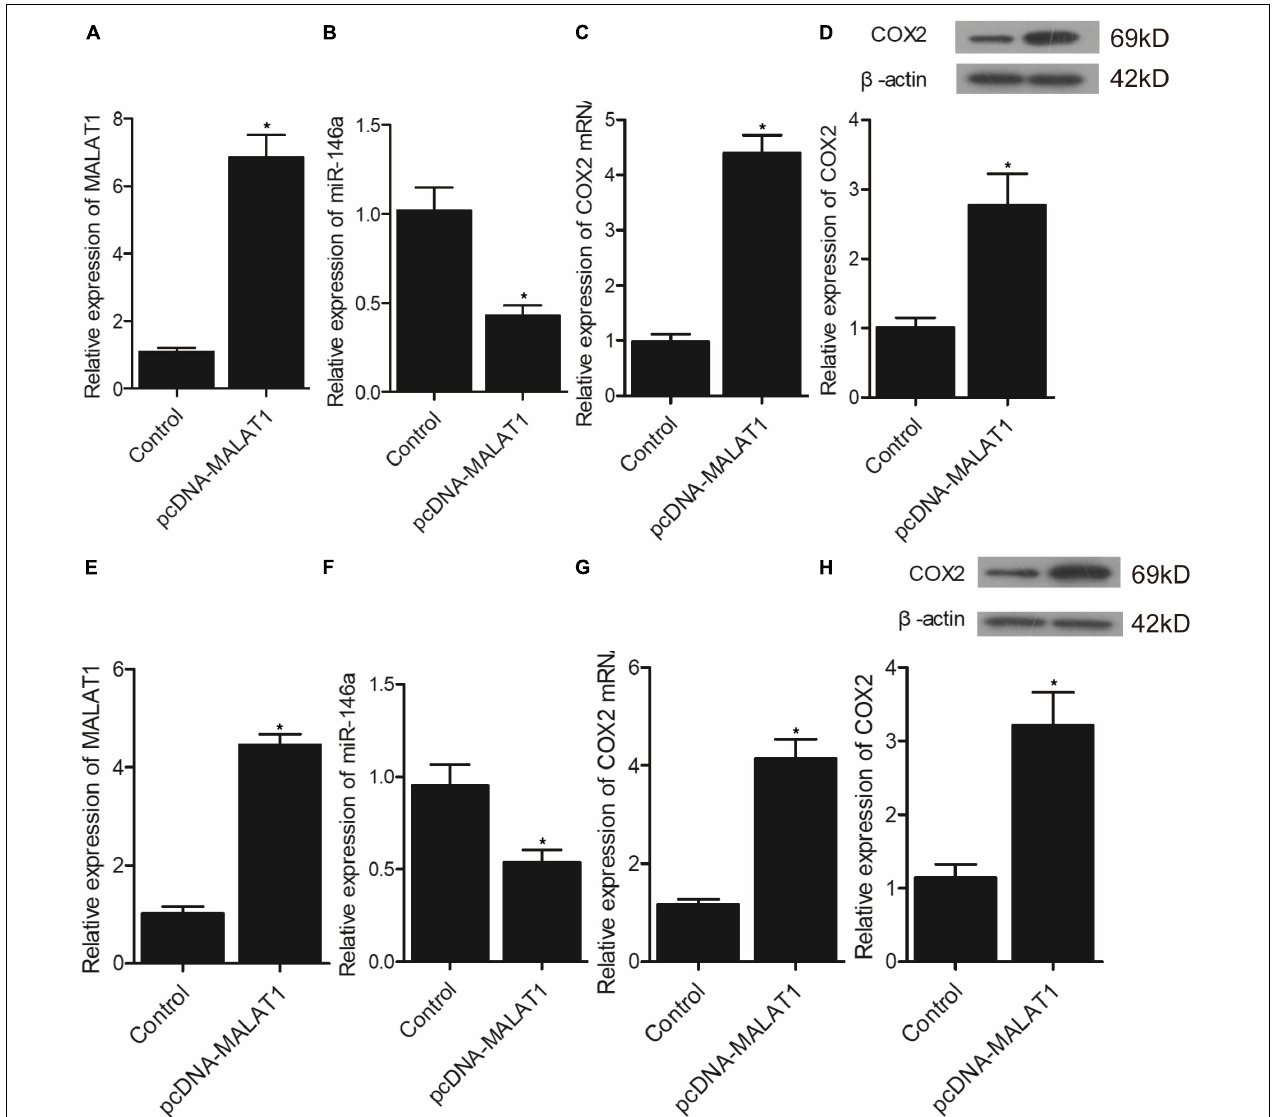
FIGURE 7 | Transfection of pcDNA-MALAT1 inhibited the expression of miR-146a but promoted the expression of COX2 mRNA/protein (* p < 0.05 vs. control group). (A) Relative expression of MALAT1 was highly increased in hPASMCs transfected pcDNA-MALAT1. (B) Relative expression of miR-146a was suppressed in hPASMCs transfected with pcDNA-MALAT1. (C) Relative expression of COX2 mRNA was promoted in hPASMCs transfected with pcDNA-MALAT1. (D) Relative expression of COX protein was boosted in hPASMCs transfected with pcDNA-MALAT1. (E) Relative expression of MALAT1 was highly increased in rPASMCs transfected with pcDNA-MALAT1. (F) Relative expression of miR-146a was suppressed in rPASMCs transfected with pcDNA-MALAT1. (G) Relative expression of COX2 mRNA was promoted in rPASMCs transfected with pcDNA-MALAT1. (H) Relative expression of COX protein was boosted in rPASMCs transfected with